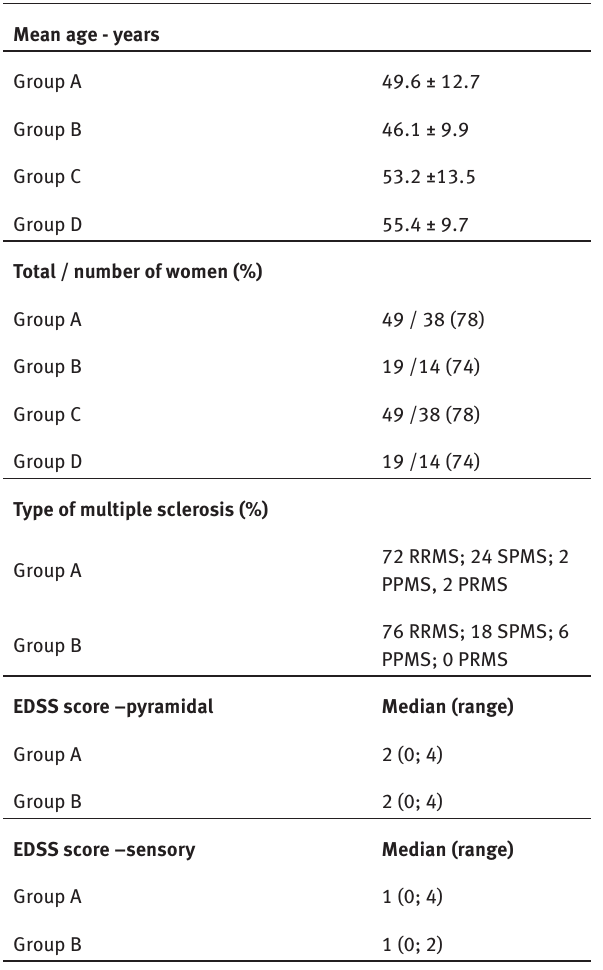
Table 1: Patient